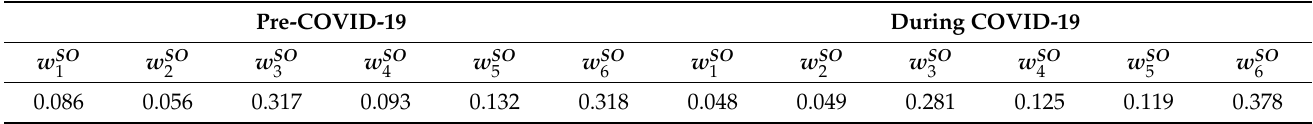
Table 10. The subjective-objective weights of the efficiency criteria pre- and during COVID-19. Pre-COVID-19 During COVID-19